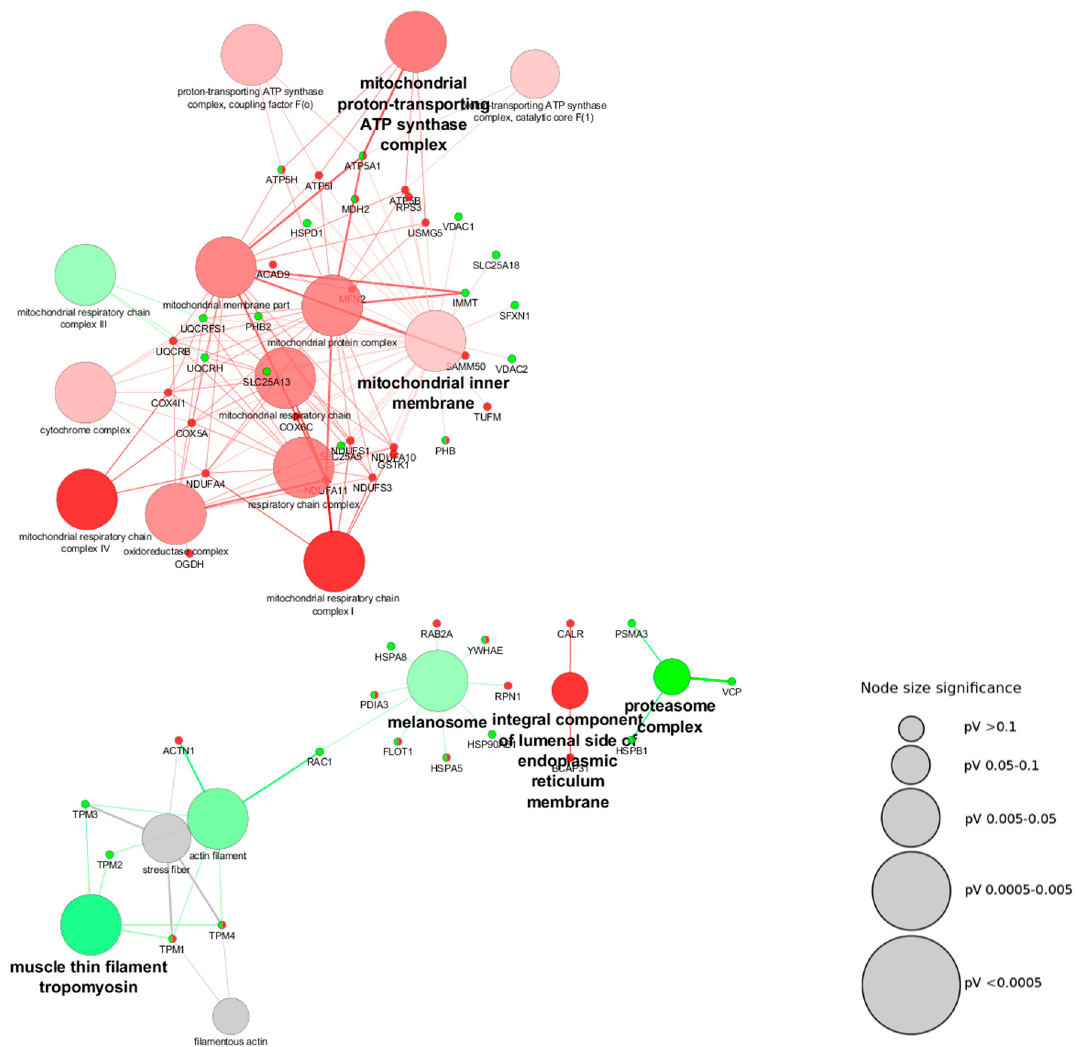
Figure 4. Cytoscape network of the main cellular components associated with mitochondrial-shaping proteins in the context of Parkinson’s disease. The binding partners of the mitochondrial-shaping proteins found to be modified in different proteomics-based approaches in the context of Parkinson’s disease according to the Human Integrated Protein-Protein Interaction rEference (HIPPIE) and appearing as modified in proteomics-based studies on Parkinson’s disease were subjected to network analysis using the plugin ClueGo from the software Cytoscape to analyze the cellular components represented by the proteins from the list. Gray scale nodes correspond to cellular components that were found to be equally up- and downregulated in different studies, while green and red nodes are representative of upregulated and downregulated cellular components respectively, in the context of Parkinson’s disease. The increase in green and red color gradient represents higher amounts of the contribution of up- and downregulated proteins, respectively. The size of the nodes is indicative of their statistical significance.